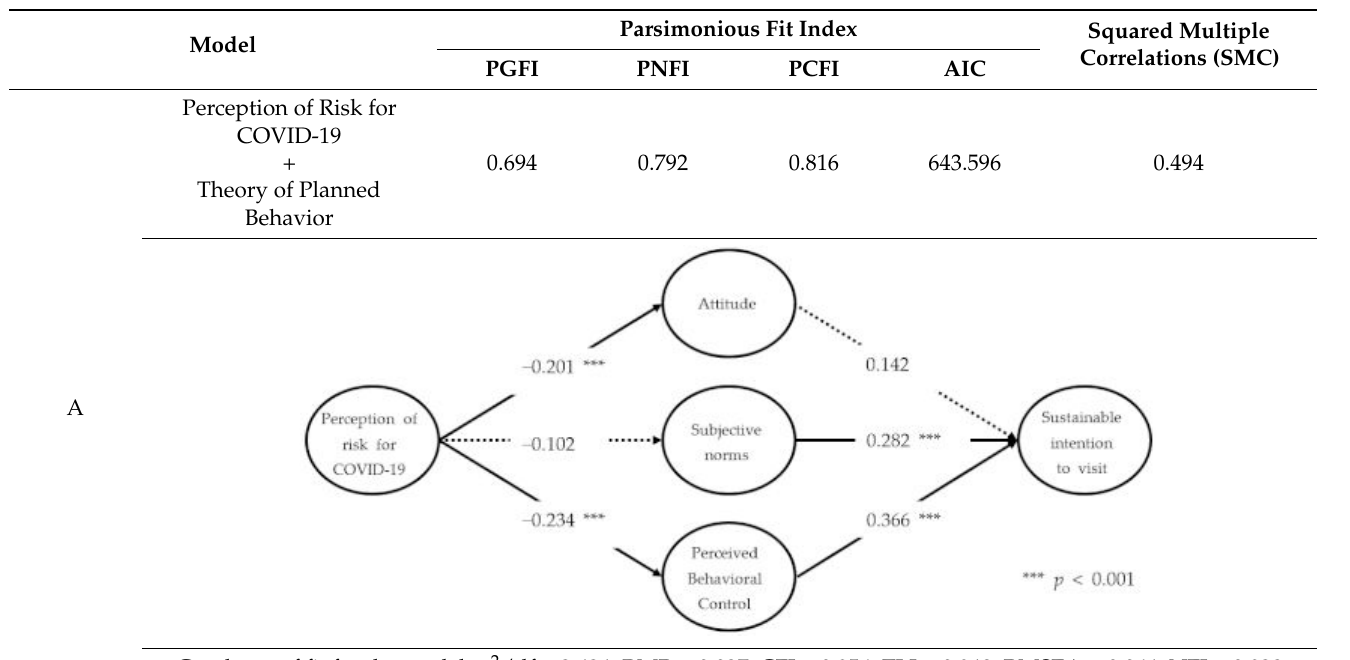
Table 5. Results of testing the research model’s